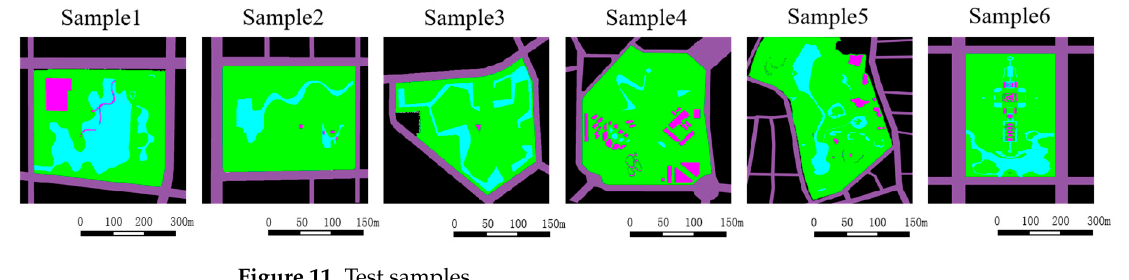
Figure 11. Test samples. Figure 11. Test